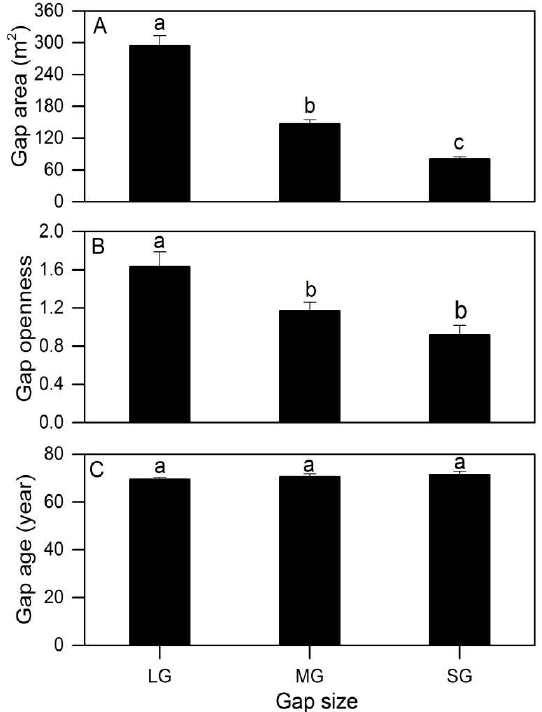
Figure A3. Gap characteristics ( A : Gap area; B : Gap openness; C : Gap age) between the different gap sizes in a subalpine coniferous forest. Error bars represent standard error. Different letters represent significant differences (Tukey’s HSD test) (Bonferroni-adjusted p -values < 0.02). LG, MG, and SG represent a large gap, medium gap, and small gap, respectively.